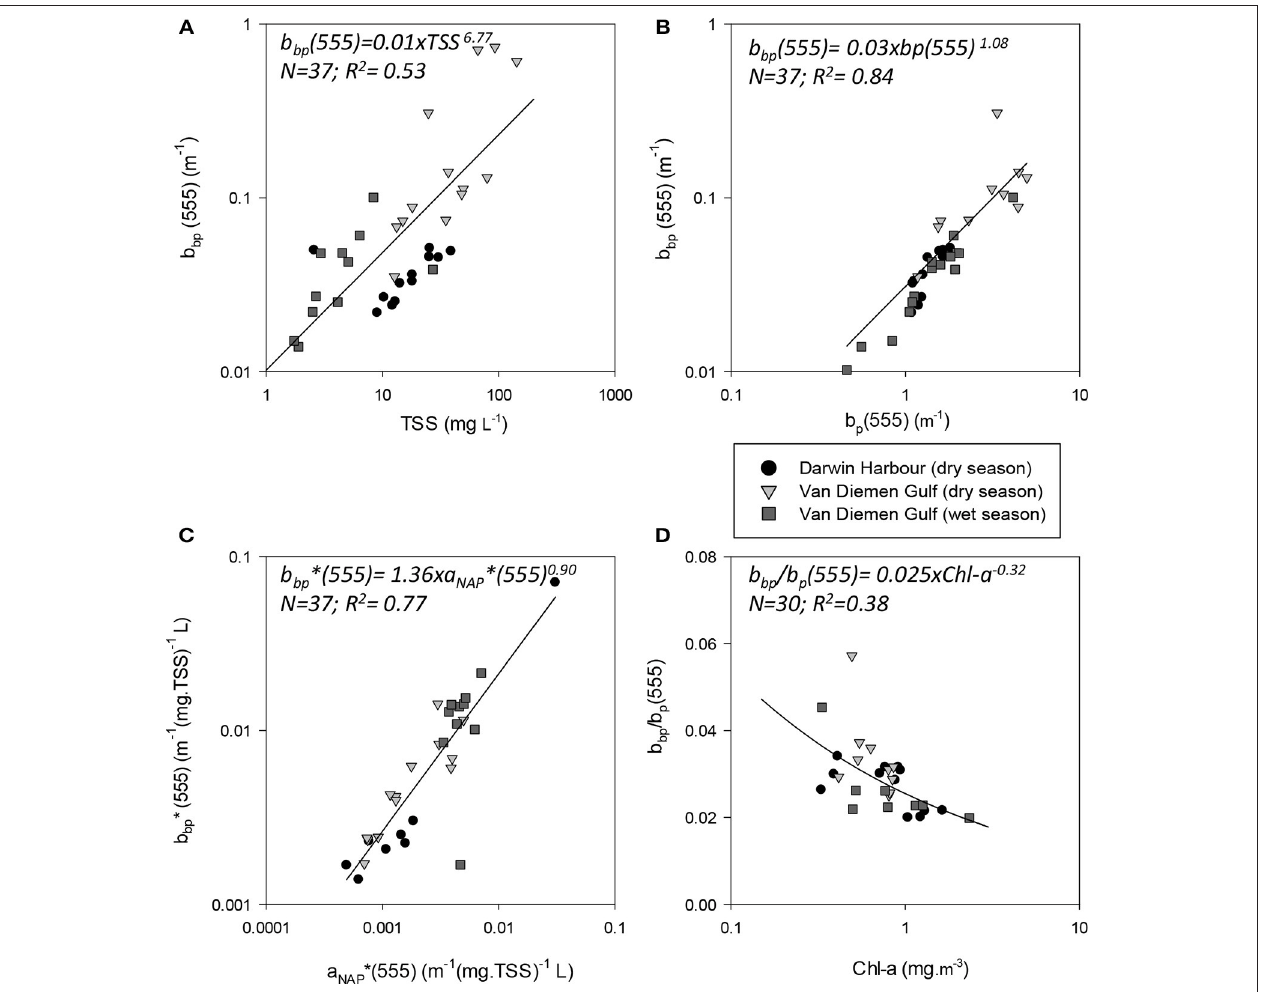
FIGURE 7 | Absorption and scattering properties of particles. Scatterplots of backscattering (b bp555 ) as a function of (A) TSS and (B) the scattering coefficient (b p555 ), (C) Mass-specific NAP coefficient and mass-specific backscattering coefficient and (D) b b (555) as a function of Chl-a.